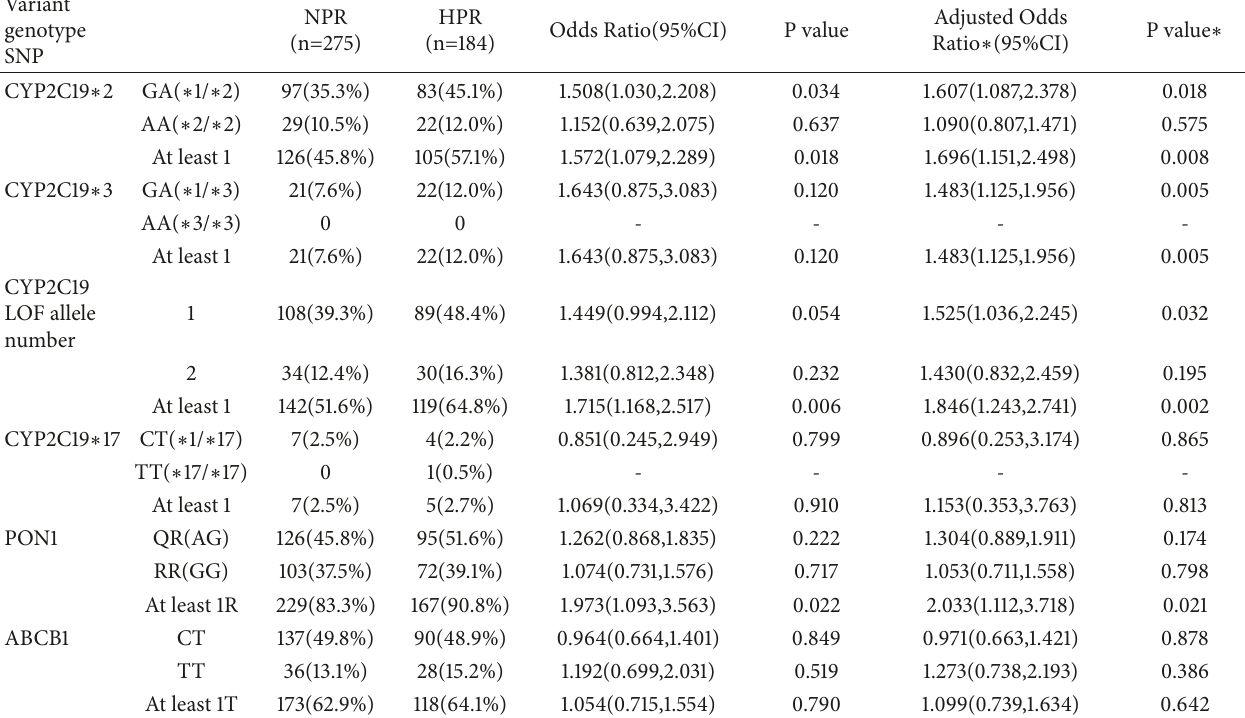
Table 3: Relationship between genotypes and platelet